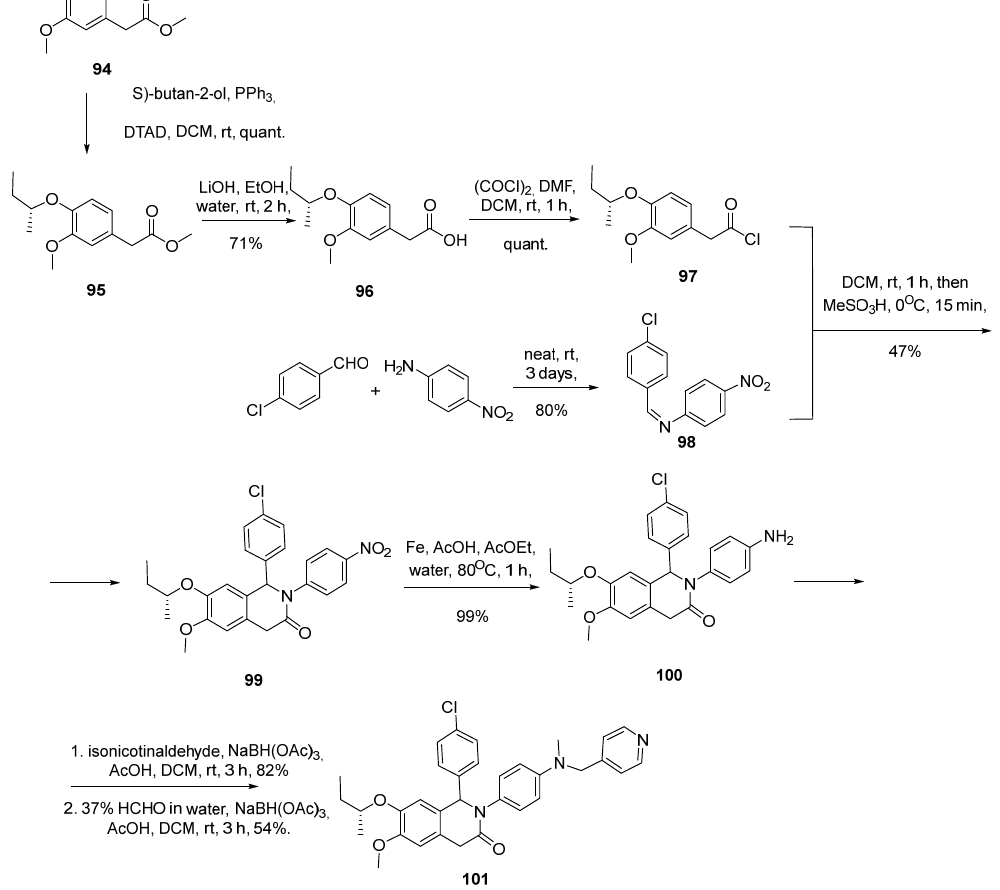
Scheme 13. The synthesis of piperidinone 101 [54].